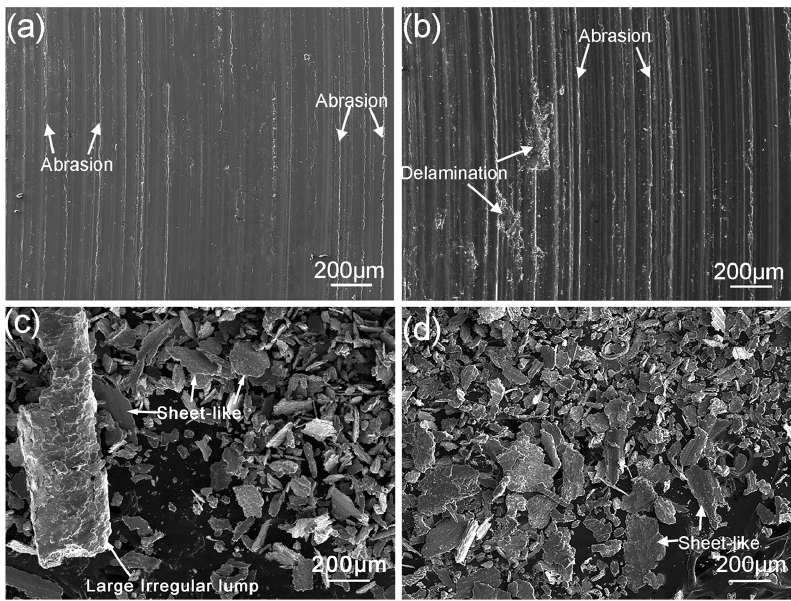
Figure 14. SEM micrograph of the worn surface and debris of surfacing alloys with 1.5%Ce under a sliding speed of 1.25 m/s and different loads. ( a , c ) 10 N; ( b , d ) 20 N.